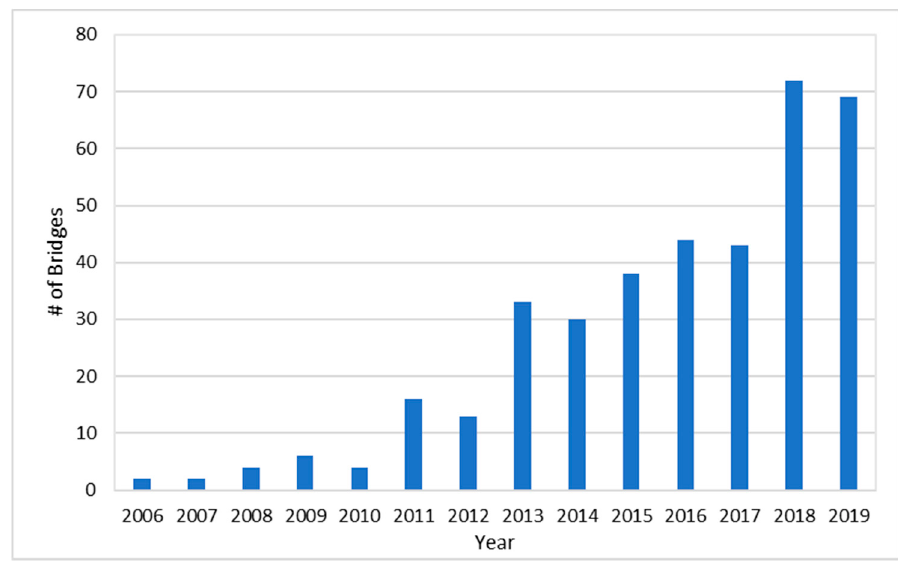
Figure 1. Number of UHPC projects each year [9].